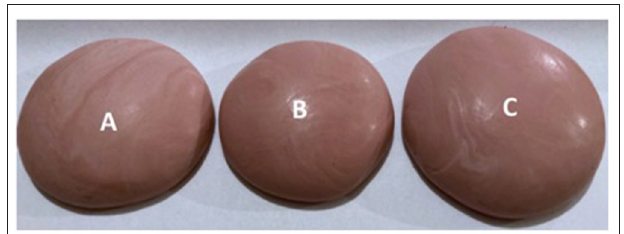
FIGURE 2 | Presentation of the tested polymers. The polymers were shaped free on a plane surface. Diameter/height (in cm): (A) 5.5/1.7, (B) 5.1/1.6, (C) 5.6/1.7.